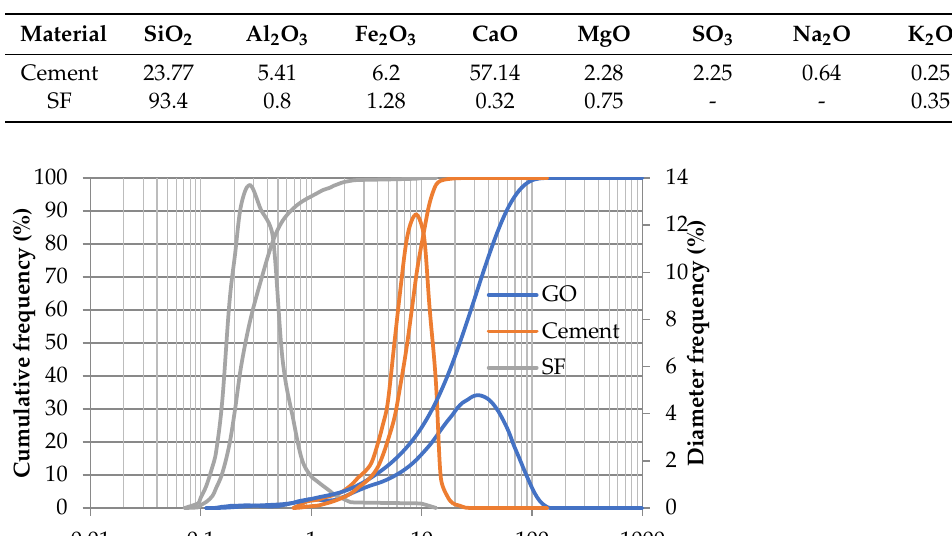
Table 1. Chemical properties of cement and SF.